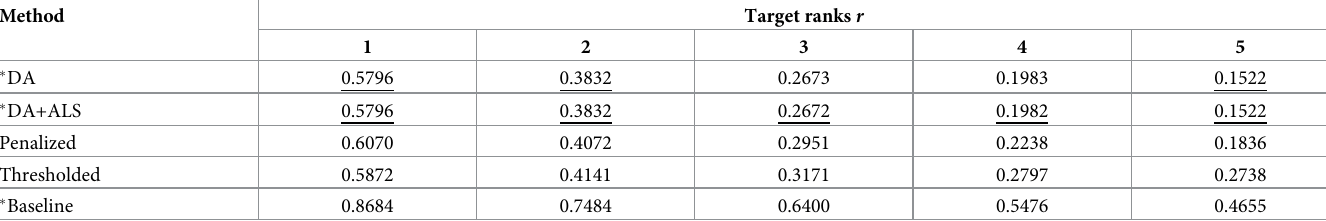
Table 5. Mean relative error for MNIST experiments. The � symbol indicates methods we propose. Best results are